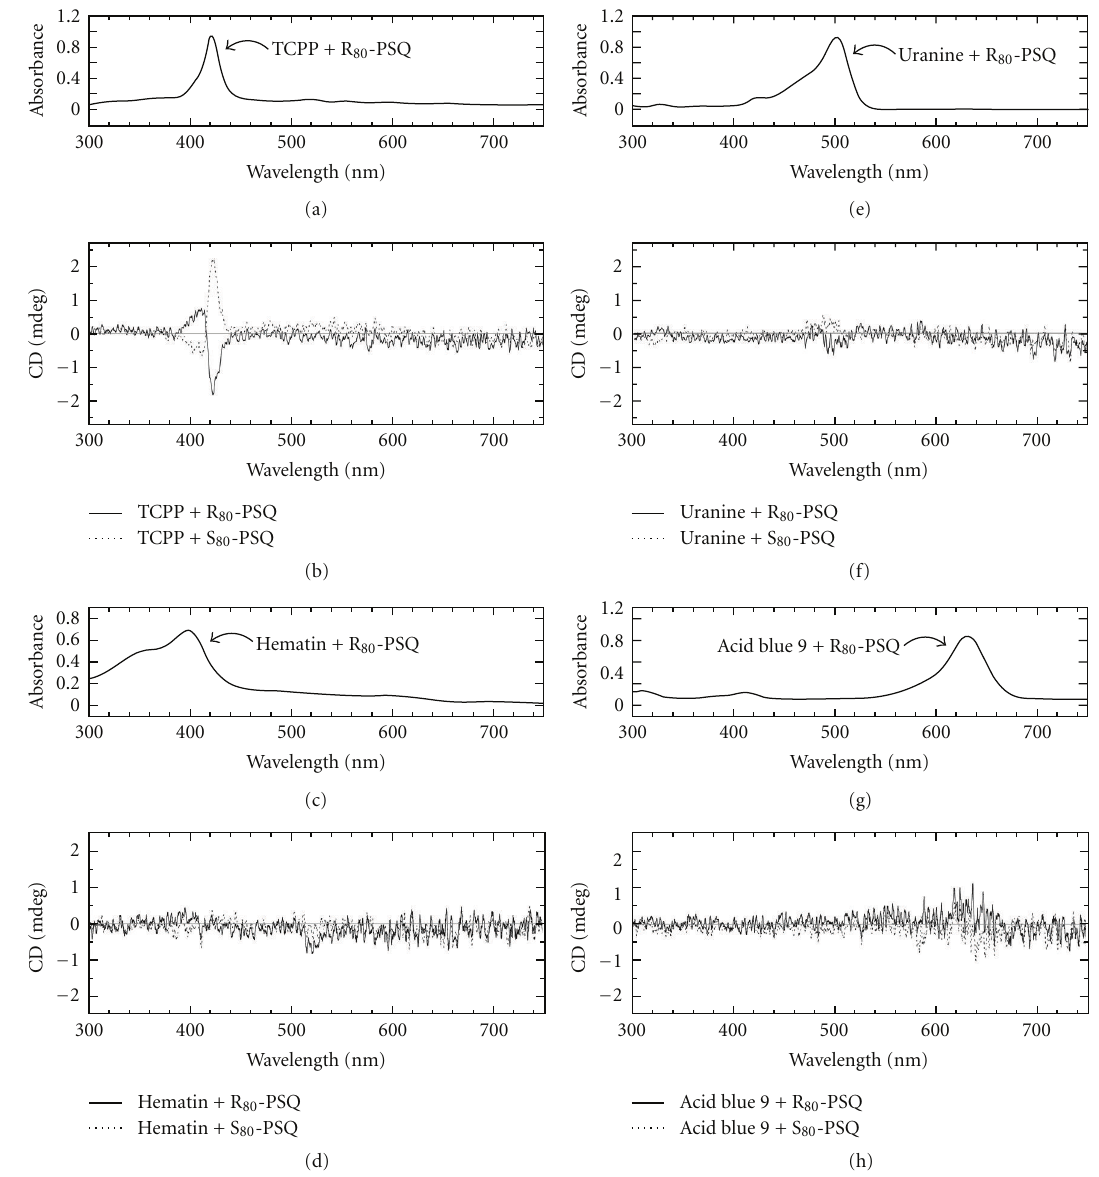
Figure 7: (a) UV-Vis spectrum of TCPP/R 80 -PSQ mixture, (b) ECD spectra of TCPP/R 80 - and S 80 -PSQs mixtures, (c) UV-Vis spectrum of Hematin/R 80 -PSQ mixture, (d) ECD spectra of Hematin/R 80 - and S 80 -PSQs mixtures, (e) UV-Vis spectrum of Uranine/R 80 -PSQ mixture, (f) ECD spectra of Uranine/R 80 - and S 80 -PSQs mixtures, (g) UV-Vis spectrum of Acid Blue 9/R 80 -PSQ mixture, and (h) ECD spectra of Acid Blue 9/R 80 - and S 80 -PSQs mixtures. In all cases, methanol was employed as a solvent, and the molar ratios of dye compound to one unit of PSQ were 1